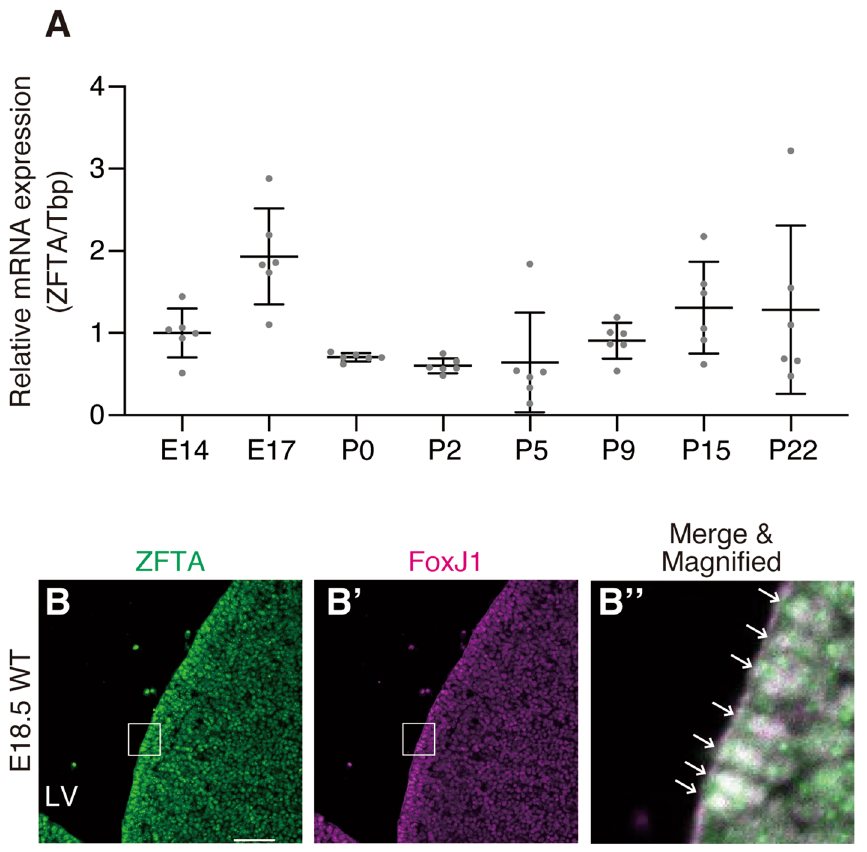
Figure 1. Expression of mouse Zfta in embryonic pre-E1 cells. ( A ) Expression profile of Zfta mRNA in the anterior portion of the lateral walls of LV assessed by qPCR. Tbp was used as an internal control. Data shown are the mean ± standard deviation (SD). Each point on the graph is the relative Zfta expression level of an individual mouse. N = 6 each. ( B – B ″ ) Coronal cryosections of wildtype (WT) E18.5 mouse embryos were stained with anti-human ZFTA (green, B ) and anti-FoxJ1 (magenta, B ’) antibodies. The merged and magnified image of the region indicated by white boxes in B and B ’ is shown in B ″ . White arrows in B ″ indicate the co-expression of ZFTA and FoxJ1 in pre-E1 cells’ nuclei (shown in white). Bar = 100